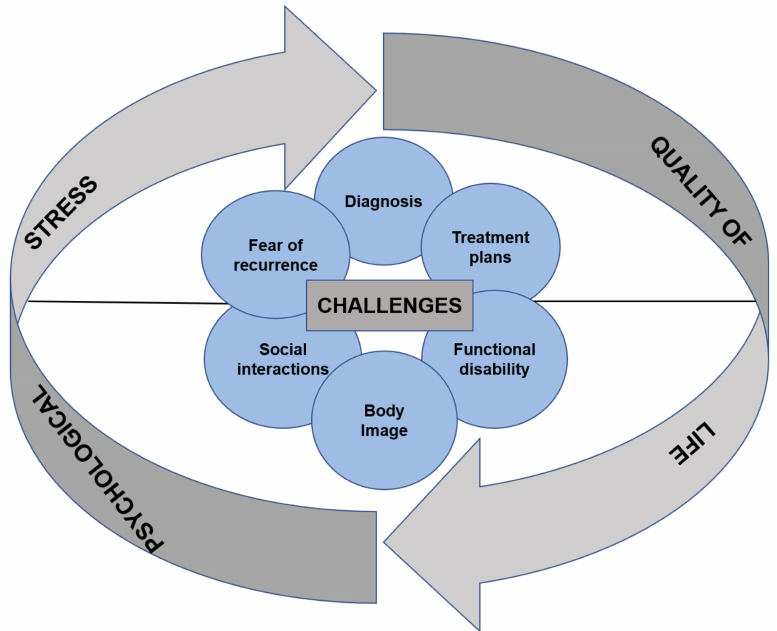
Figure 1. Summary of the challenges associated with head and neck cancers. The diagnosis itself, complex treatment plans, functional disability in terms of speech and mastication, concerns around body image that in turn lead to compromised social interactions, and fear of recurrence (FCR) are some of the challenges faced by the patients with head and neck cancers (HNC). These challenges decrease the quality of life (QoL) and increase psychological